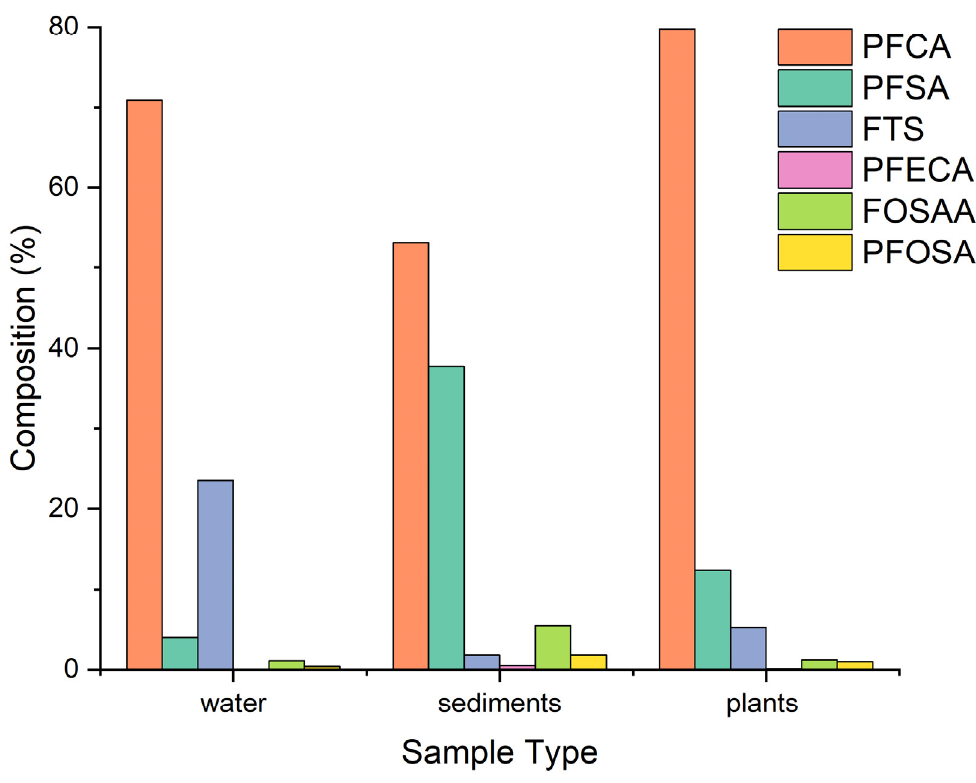
Figure 5. Percentage composition of different classes of PFAS in water, sediments, and plants.